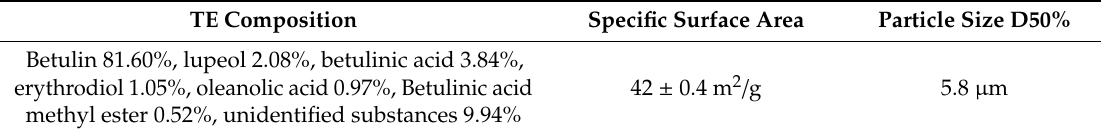
Table 1. Physicochemical characteristics of the dry birch bark extract used